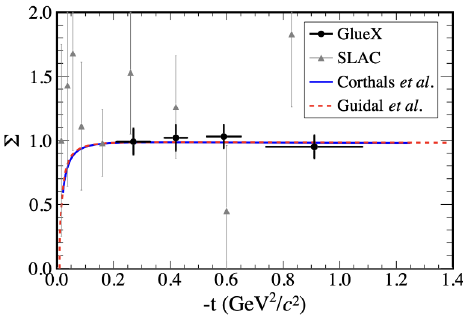
Figure 6. GlueX results for the beam asymmetry Σ in bins of momentum transfer 2 for Σ 0 photoproduction − t = − ( p − p K + ) beam based on about 20% of GlueX-I are shown in black. The grey triangles show previous measurements carried out at SLAC [13] at E γ = 16GeV. The data is compared to two model calculations by Corthals et al. [14, 15] and Guidal et al. [16], both predicting a beam asymmetry of almost one over the measured t-range. Taken from Ref.